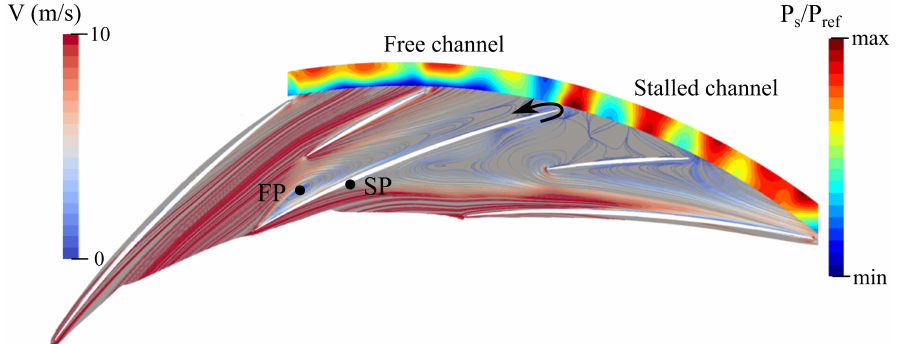
Figure 15. Friction lines colored according to the velocity at the diffuser hub and the static pressure radial cut at the diffuser outlet at